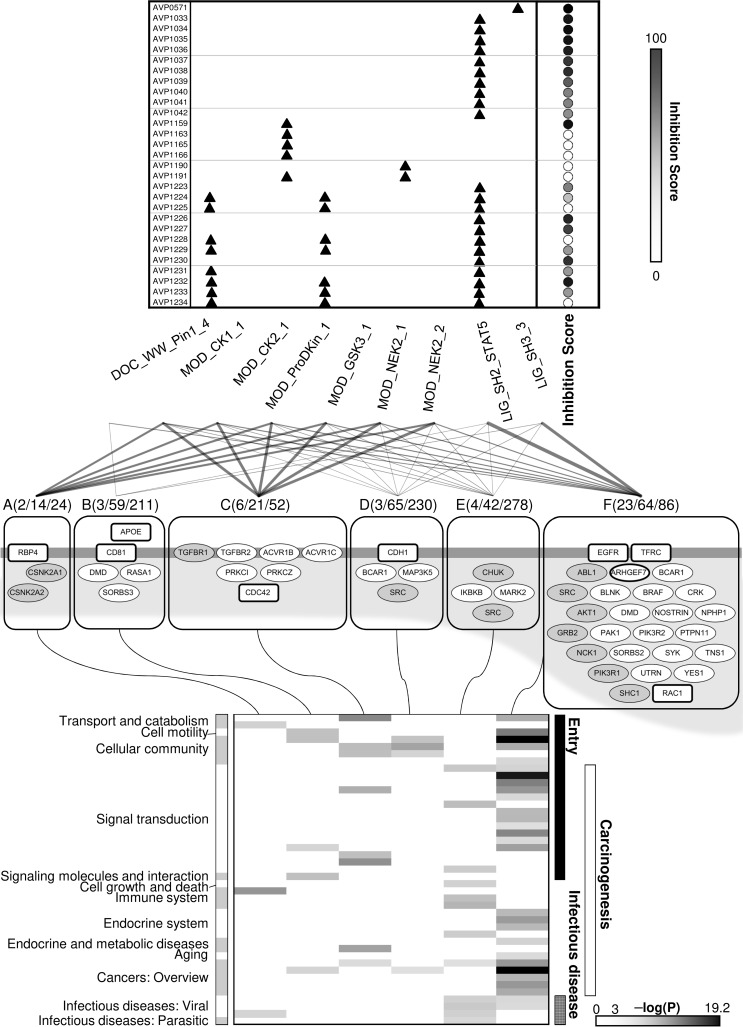
The AVP/SLiM-protein complex map.Top panel: (left column) a list of AVPs with their AVPdb identification numbers that have an amino acid sequence containing one or more HCV E1/E2 SLiMs (indicated by the triangles and named at the bottom of the panel) that can bind to a subunit of a protein complex belonging to one of the six main complex groups. The relative efficacies of these AVPs in inhibiting HCV entry according to data provided in the AVPdb [56] are indicated by the circles column in the panel with the shading score shown to the right of the panel. Middle panel: the network connecting the nine SLiMs to their group A-F complex target(s). Within each group are VIPs of all the complexes: ovals represent VIPsdirect (gray ovals are R6 VIPsdirect), and rectangles represent VIPsindirect (not all VIPsindirect are shown). The ovals and rectangles in bold outline are known HCV entry factors. The horizontal bar represents the plasma membrane, the VIPs below the bar and within the shaded area are ‘peripheral membrane proteins’, and those spanning the bar are ‘integral membrane proteins’. APOE is a peripheral membrane protein located at the extracellular side of the cell membrane. A connection between a viral SLiM and a complex group indicates that at least one protein in the group is targeted by HCV E1 and/or E2 via the viral SLiM. The thickness of the connection roughly scales to the number of proteins targeted by the SLiM in the group. The three numbers in the parenthesis are the number of VIPsdirect, total VIPs (i.e., VIPsdirect plus VIPsindirect), and unique subunits in the complex group. Bottom panel: the KEGG pathways enriched in the complex group (Benjamini-Hochberg adjusted P < 0.001) (see S6 Table for the pathway names). The gray scale at bottom right indicate the significance of the P-values. The functions of the individual KEGG pathways are shown at the left of the panel and the main functionality at the right of the panel.